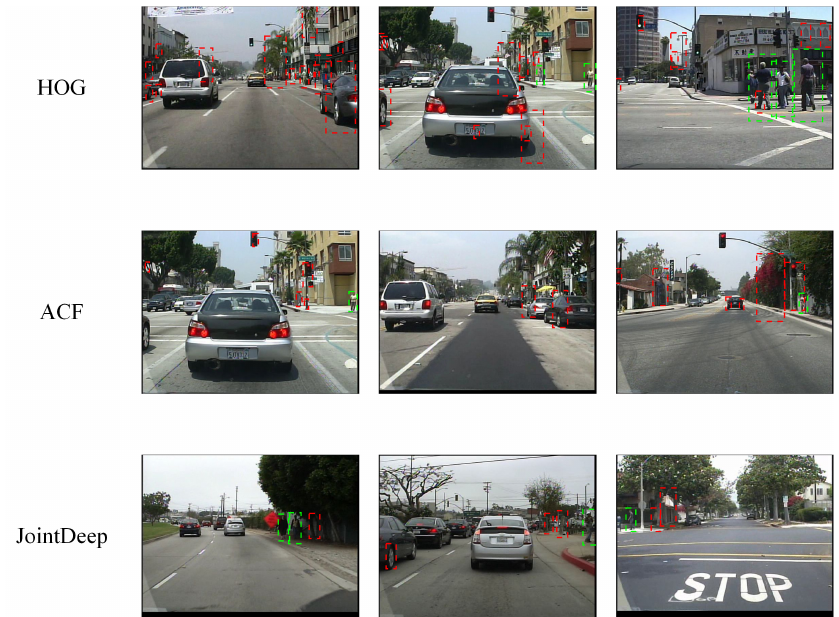
Figure 1. Many algorithms detect many candidate boxes with no pedestrian. Green boxes are true positives. Red ones are false